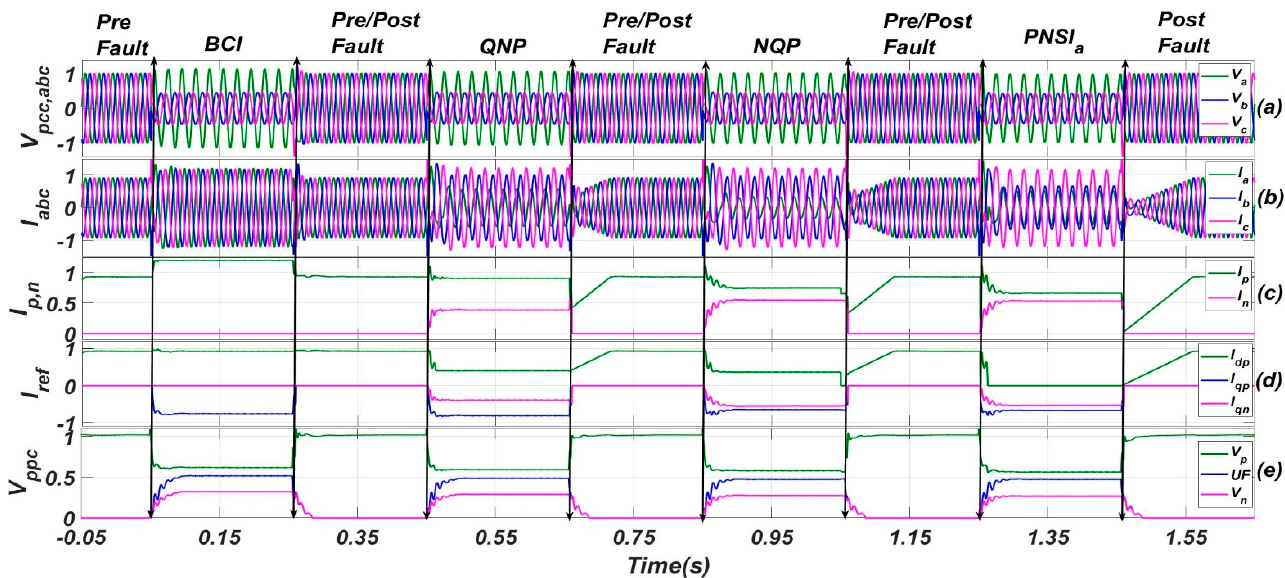
Figure 12. Performance comparison of different schemes for DLG Fault. ( a ) instantaneous three phase voltages (phase to neutral) at PCC, ( b ) instantaneous three phase converter’s currents, ( c ) magnitude of positive and negative sequence current phasor, ( d ) reference current components for positive and negative sequences, ( e ) magnitude of positive and negative sequence voltage phasor along with unbalanced factor.